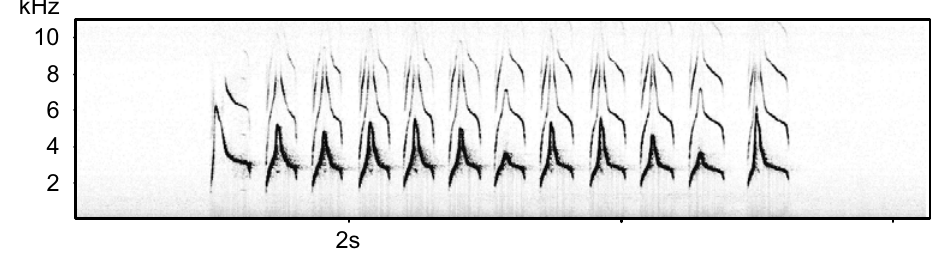
Fig. 2 – Far ranging contact call of an Arabian